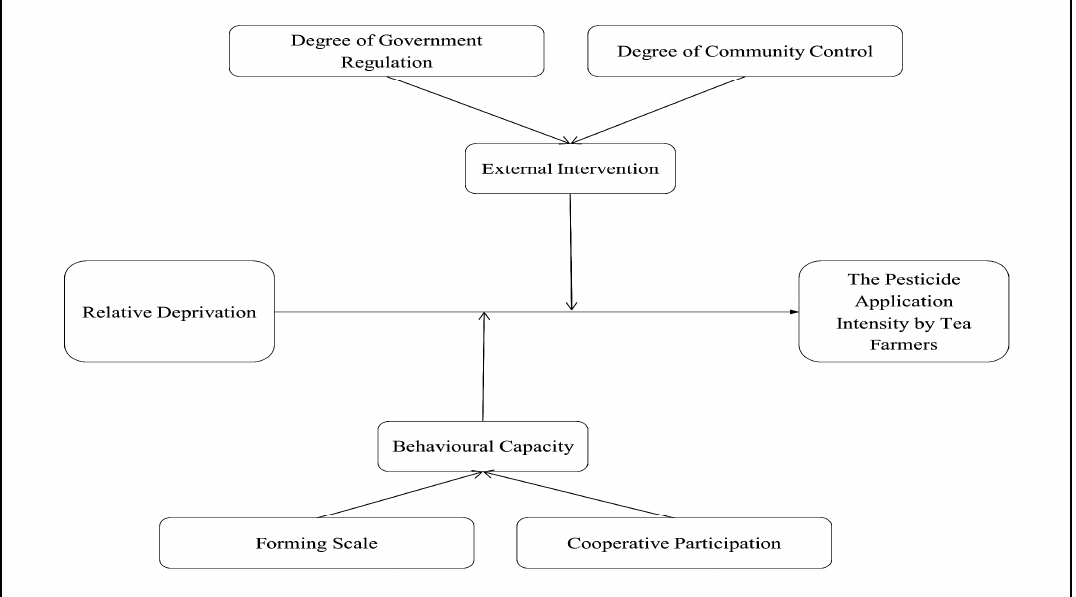
Figure 1. Theoretical framework.